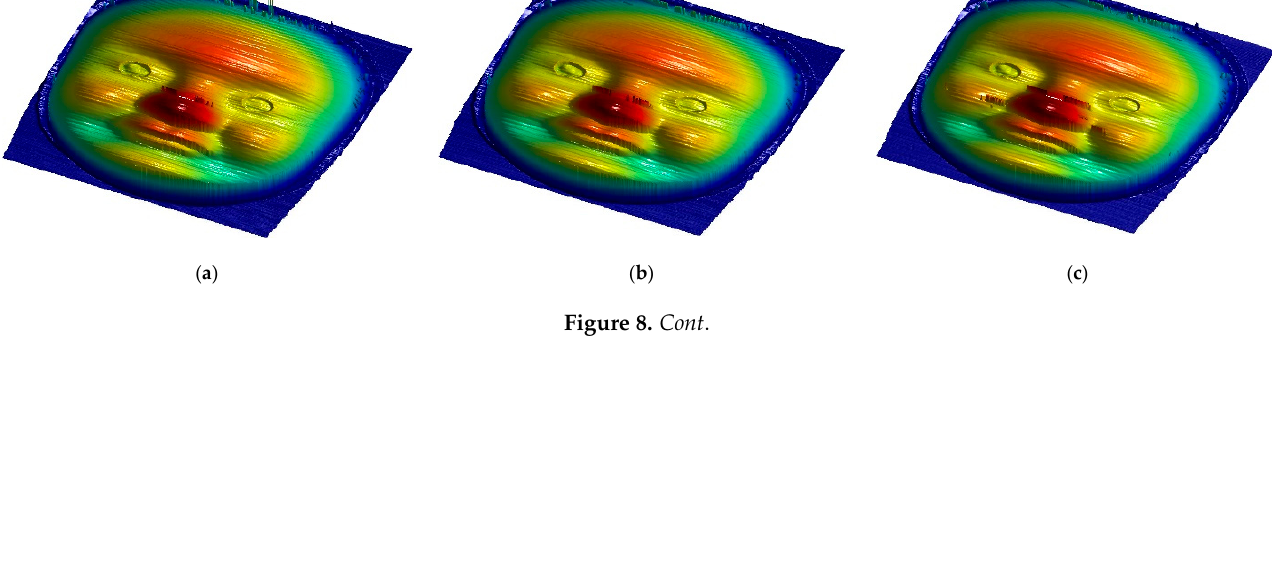
Figure 7. ( a ) The cross sections of the normalized intensity for the third coding pattern; ( b ) The respectively detected codewords.